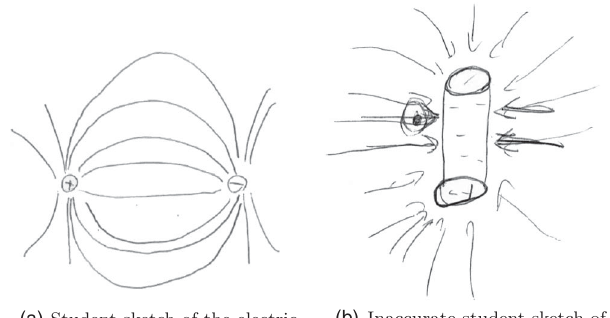
FIG. 4. Examples of student drawings of electric